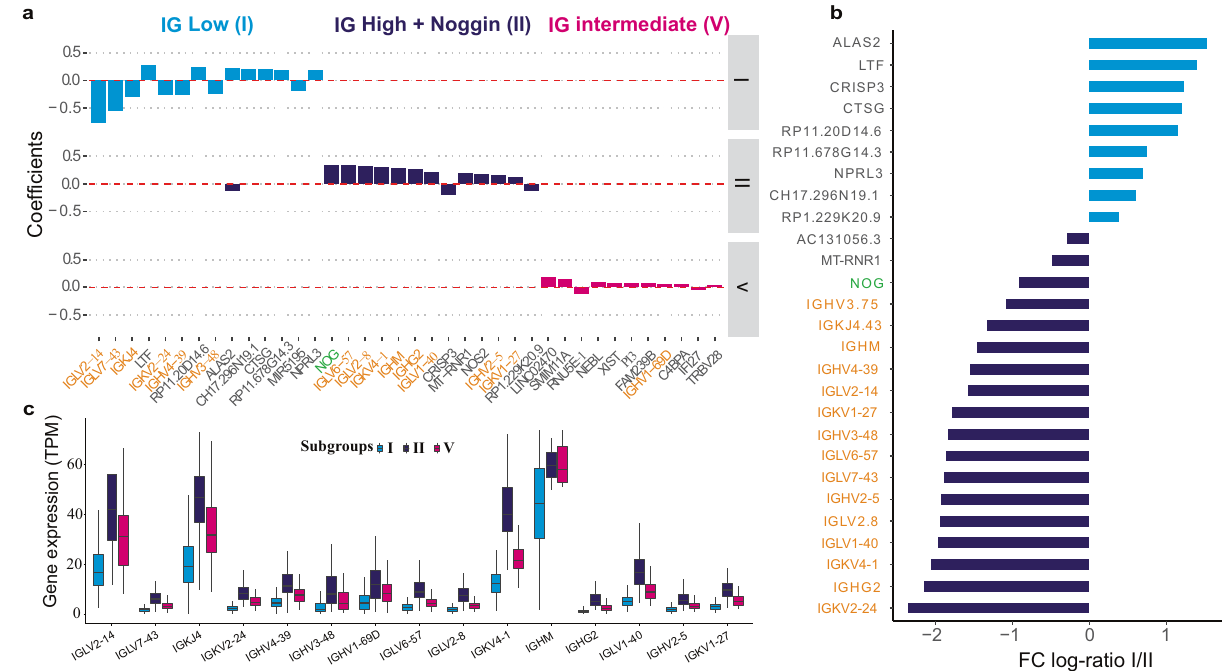
Fig. 3 Genes associated with subgroups I (low survival), II (high survival) and V (intermediate survival). a Genes with the highest 5% of LASSO coef fi cients across subgroups I, II and V. b Average expression fold change (log 2 scaled) of the signature genes between subgroup I and II, with signi fi cance notations. Genes over-expressed in subgroup I are denoted by light blue bars while genes primarily expressed in subgroup II are represented by dark blue bars. c Expression level of immunoglobulin genes selected by LASSO across the three predominant subgroups with medians shown. Subgroups I ( n = 134), V ( n = 98) and II ( n = 119) can be de fi ned as having low, intermediate and high immunoglobulin characteristics. Vertical centre line represents the median, top and bottom bounds of the box represent the fi rst and third quartile, while the tips of the whiskers represent min and max